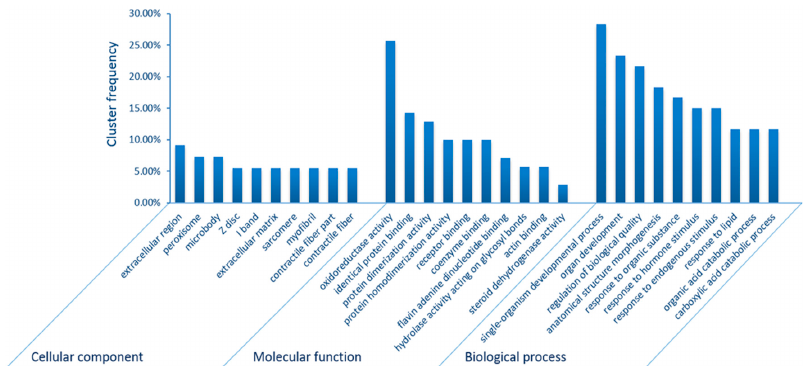
Figure 2. Enriched Gene Ontology (GO) analysis of differentially expressed proteins in the intestine under heat stress. The top 10 enriched GO-terms by cluster frequency in “Cellular component”, “Molecular function” and “Biological process” were shown, respectively. Table 4. Enriched pathways of different expressed proteins (heat stress (HS) vs. Control).